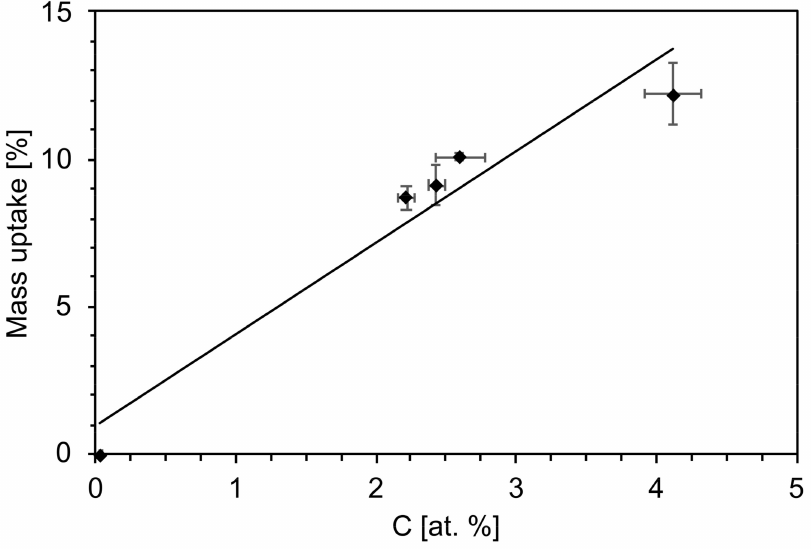
Figure 11. Relation between the foam mass uptake and the carbon content by increasing the aging